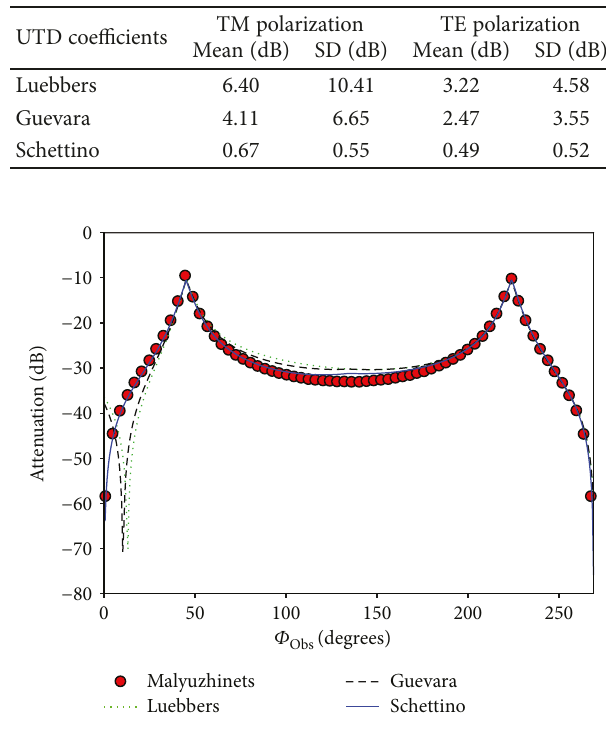
Figure 5: Attenuation of the di ff racted fi eld for TM polarization around the wedge; incidence on both faces at ϕ i = 3 π /4